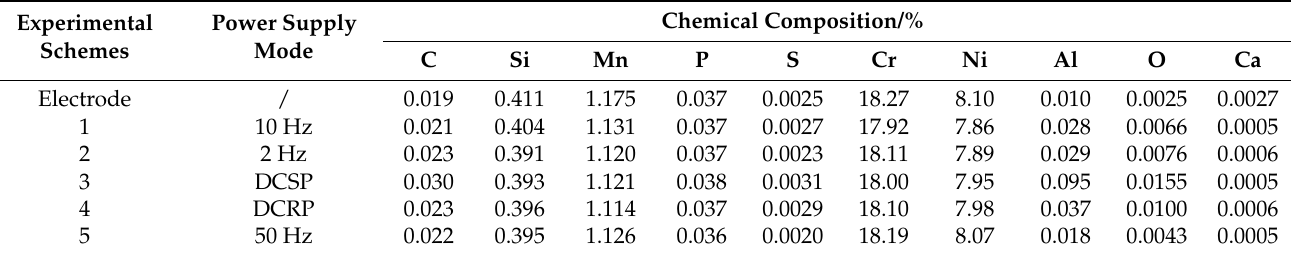
Table 3. Chemical composition of electroslag